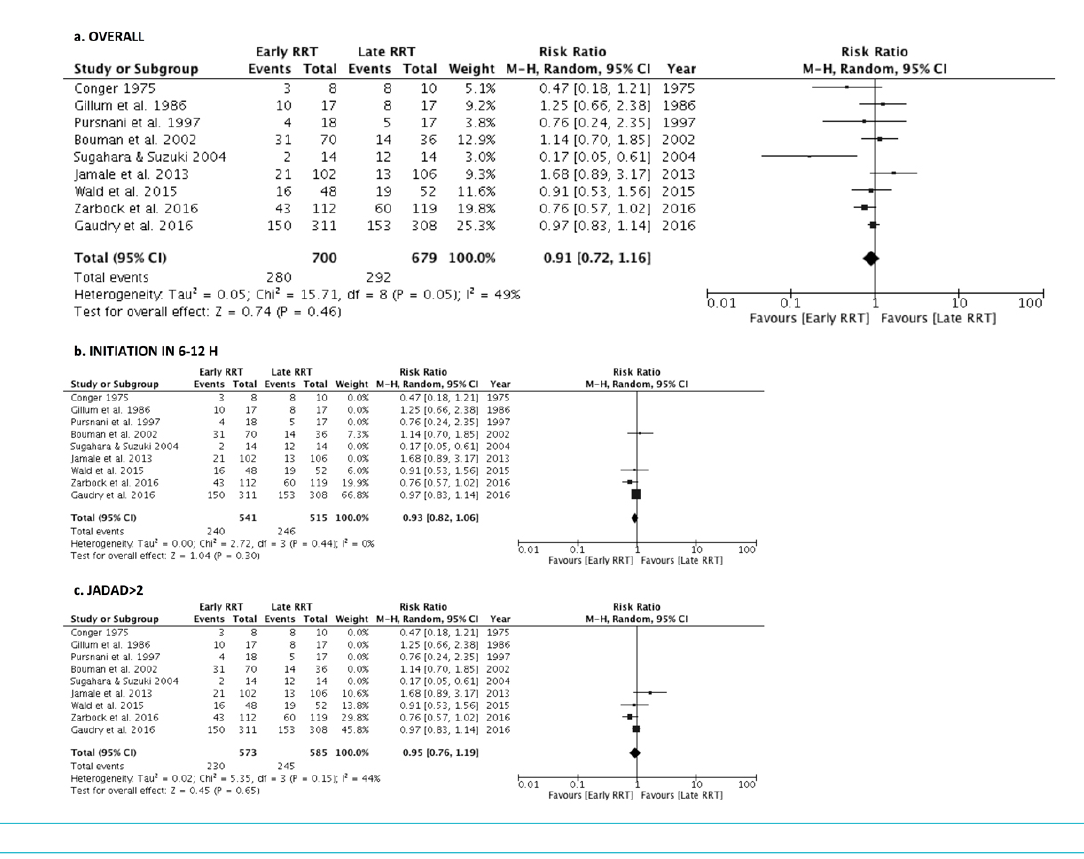
Figure 2: Forest plot demonstrating the impact of early renal replacement therapy on in-hospital or 60-day mortality compared with late renal replacement therapy. (a) All studies in patients with acute kidney injury (AKI) were included. (b) Only the trials that offered renal replacement therapy within 6 to 12 hours of eligibility were included. © Only studies with a Jadad score >2 were included. Data are presented as risk ratios with 95% confidence intervals. A random-effects model was used.